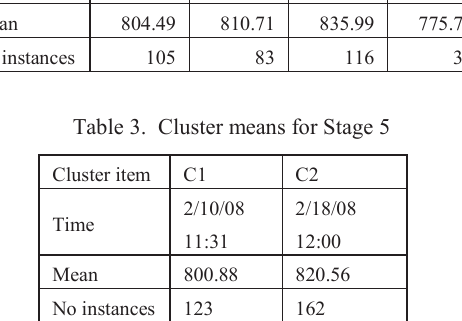
Fig. 5. Slurry usages at Stage 2 after applying smoothing techniques